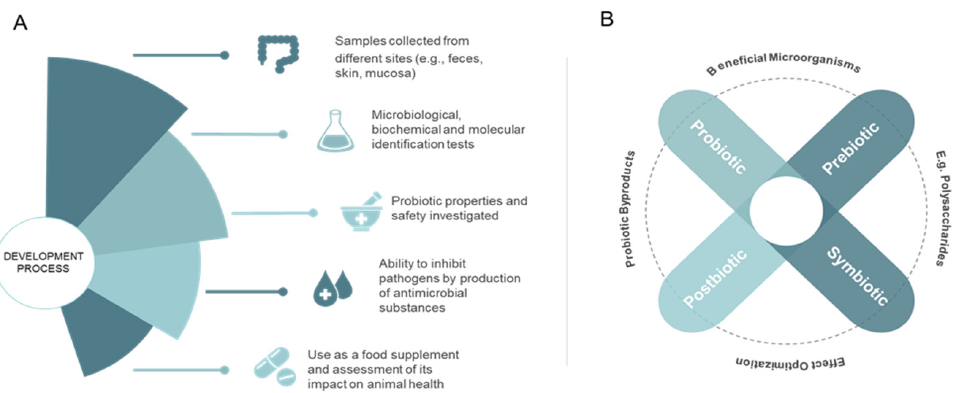
Figure 1. Probiotics development processes for feed and techniques to improve probiotic supplementation effects. ( A ) The different stages before probiotic bacteria use in aquaculture. From a sample, tests to identify genus and species are performed. Then, tests with and without the use of living organisms evaluate its properties and use as a food additive in animal feed. ( B ) In order to optimize aquaculture production processes, different techniques have been used. Probiotic microorganisms are those that confer benefits to the host; prebiotics are nondigestible food components that benefit the colonization of certain bacteria, such as probiotics; synbiotics are the combination of probiotics and prebiotics in the same product; mixtures of probiotics are prepared from the combination of more than one probiotic microorganism to potentiate their action; and postbiotics, dead probiotics or byproducts, are commonly associated with safety [38–40,42]. Table 1. Overview of probiotic effects on fish health or against aquaculture pathogenic bacteria.